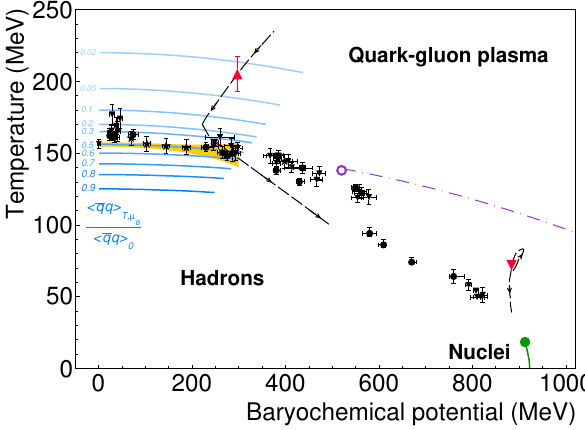
Figure 1. QCD phase diagramme. Experimental black points were obtained from a fit using statistical hadronization model to the hadron yields measured in various Heavy ion experiments [4]. The expectation values of the chiral condensate relative to the vacuum as constrained by the lattice calculations [2] are depicted as blue curves. The yellow band is the crossover re- gion. The dotted–dashed purple curve shows the conjectured first-order phase transition, which terminates in a second-order QCD critical point (open purple circle), whose exact location is a matter of debate. The red upright triangle displays the tem- perature deduced from the dielepton measurements (see text for details). Lines with arrows show hypothetical trajectories for HI collisions at SPS and SIS18. Figure taken from